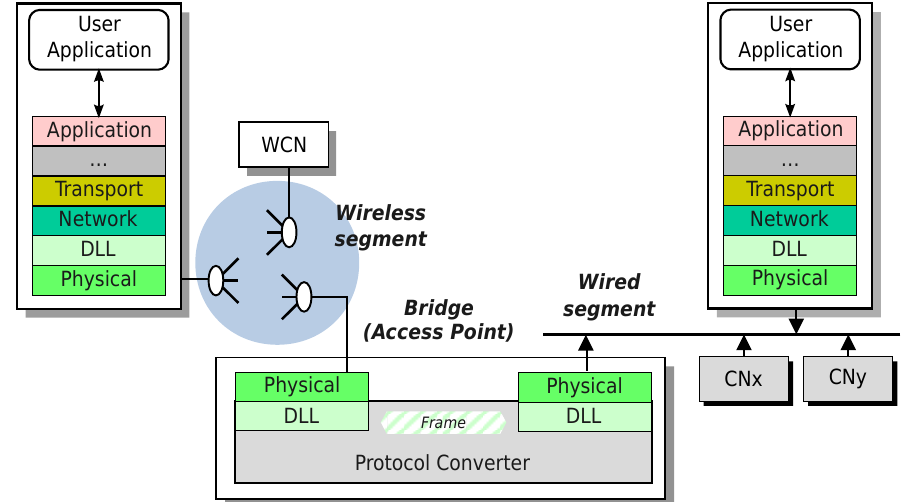
Figure 1. An Access Point serving as a bridge between a wireless extension of a wired